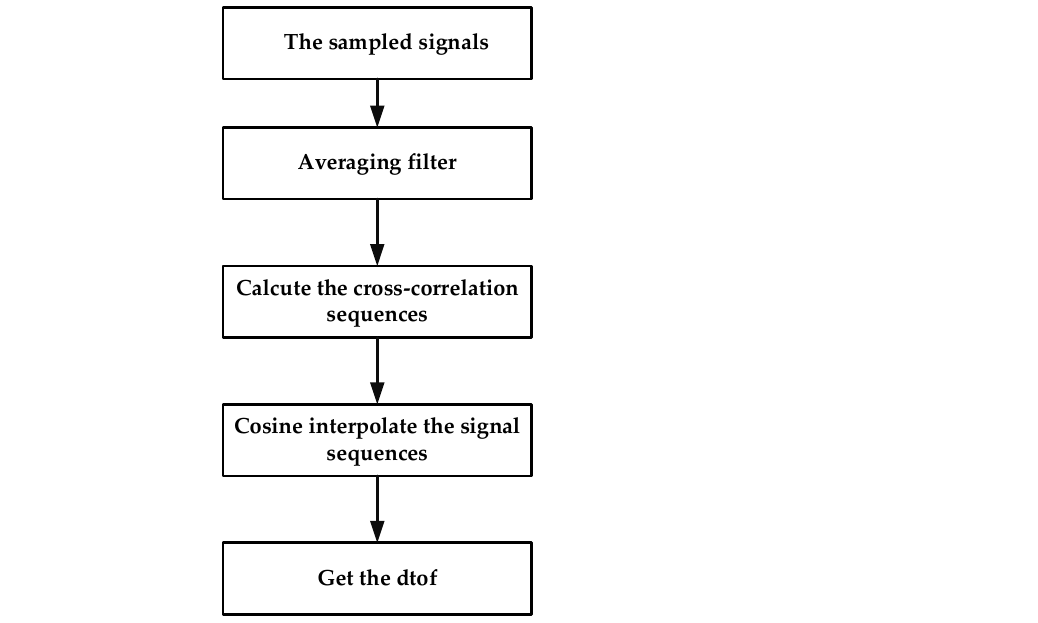
Figure 8. The overall algorithm of the flow sensing system.